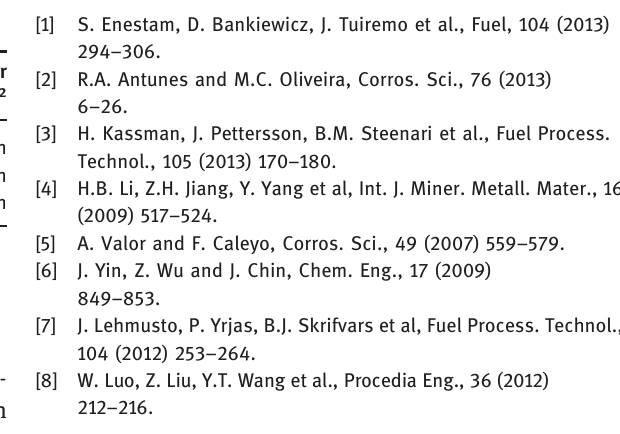
Table 4: Comparison analysis of fitting function for 3xx material in different